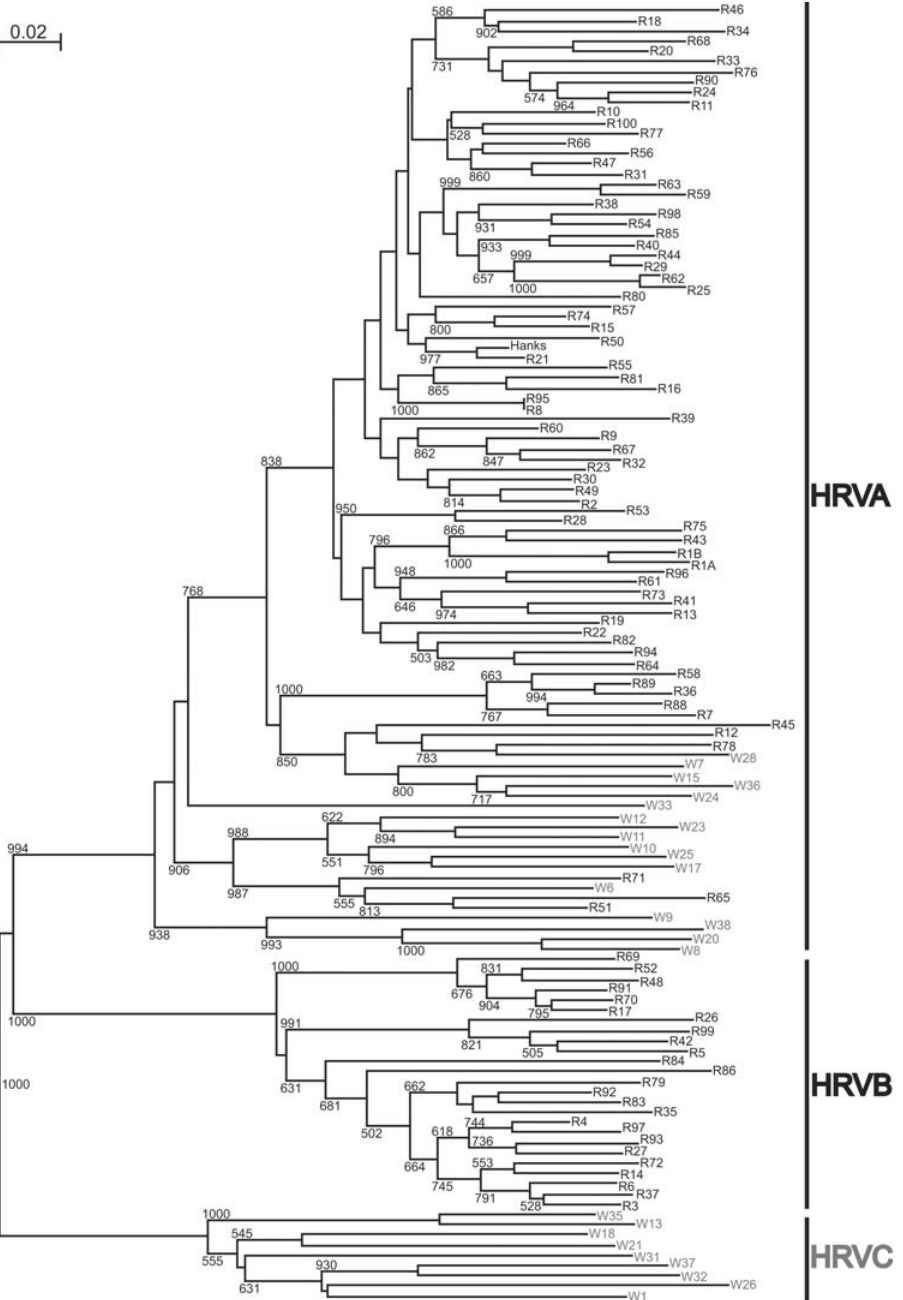
Figure 4. Phylogenetic tree depicting the relationships among 101 HRV serotypes (R) and 26 new strains (W) in the P1-P2 region of 5’NCR. This tree was generated as described in Figure 3. None of the new strains clustered with HRVB viruses. Seventeen new strains (blue) belonged to HRVA group, and 9 strains (red) cluster into a new group (‘‘C’’) that is separate from groups A and B.